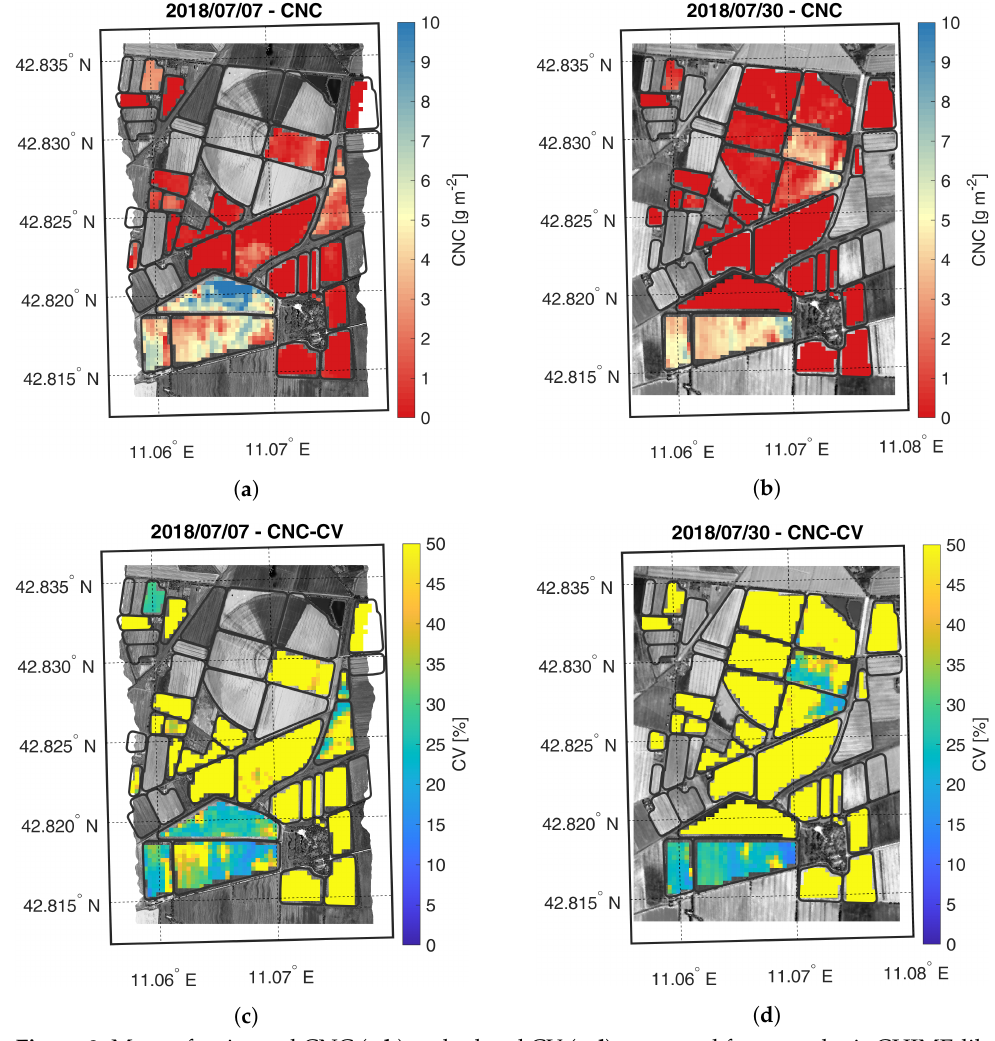
Figure 8. Maps of estimated CNC ( a , b ) and related CV ( c , d ) generated from synthetic CHIME-like images, simulated from the Hyplant-DUAL dataset acquired on 7 and 30 July